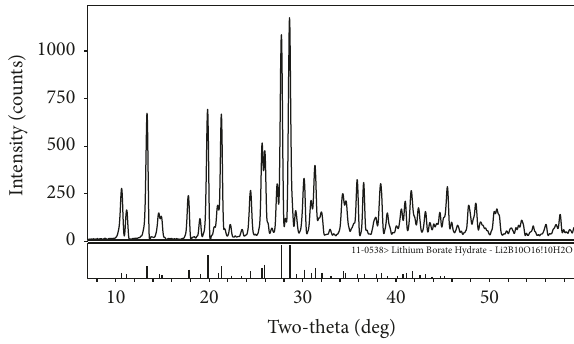
Figure 1: The X-ray diffraction pattern of LiB 5 O 8 ⋅ 5H 2 O.